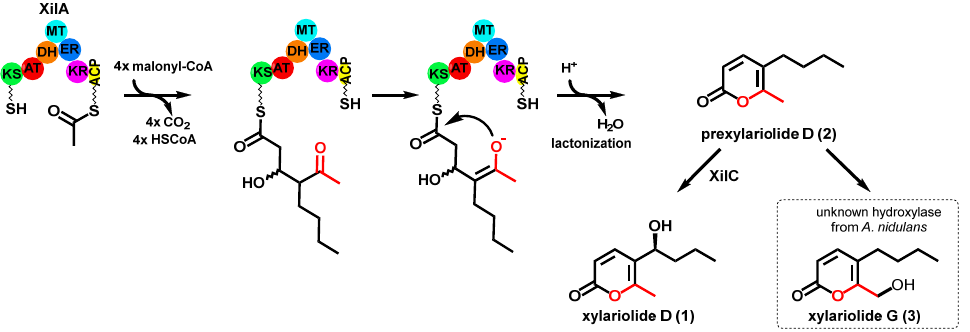
Figure 4. Proposed biosynthetic pathway for the formation of xylariolide D in P. crustosum, including a branching step during the polyketide chain elongation as well as formation of xylariolide G in A. nidulans.